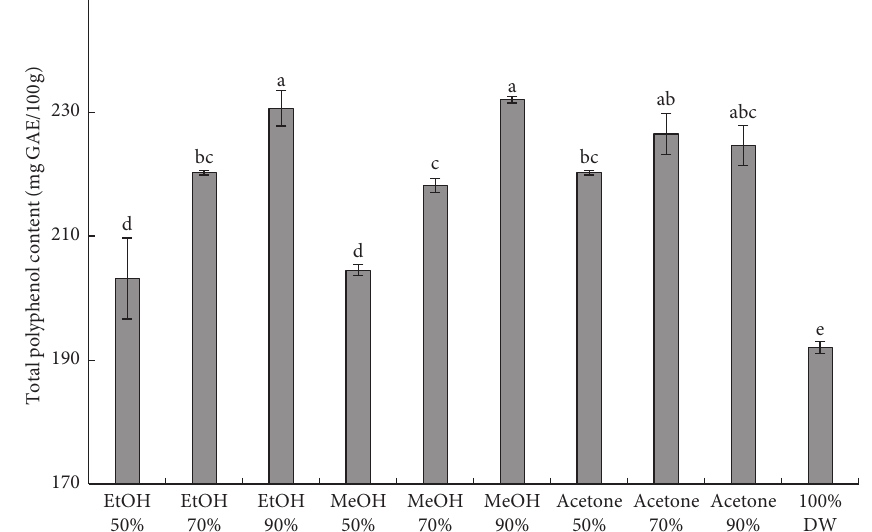
Figure 1: Effect of solvent on the TPC of olive leaf extract. Means with different superscripts ( a–e in the same column) differ significantly ( P < 0 . 05). All values represent means ± standard deviations for three replicates.